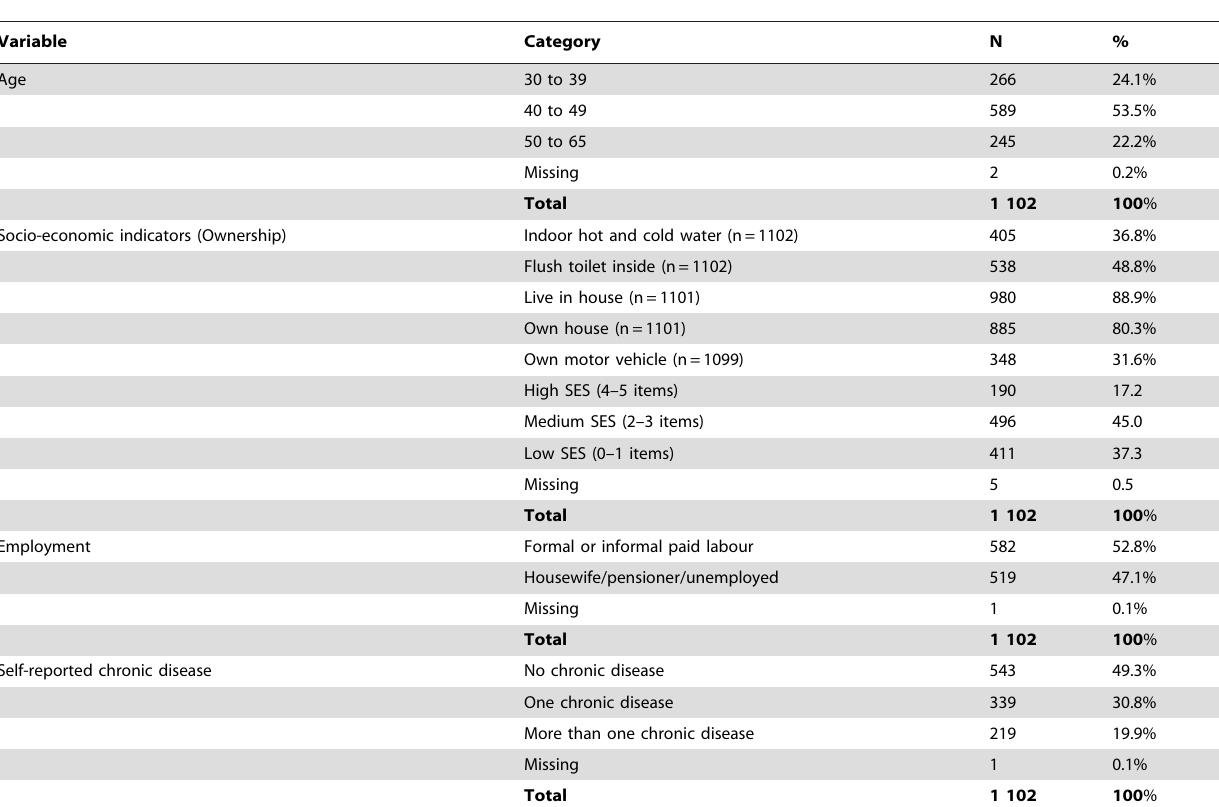
Table 1. Population Characteristics.